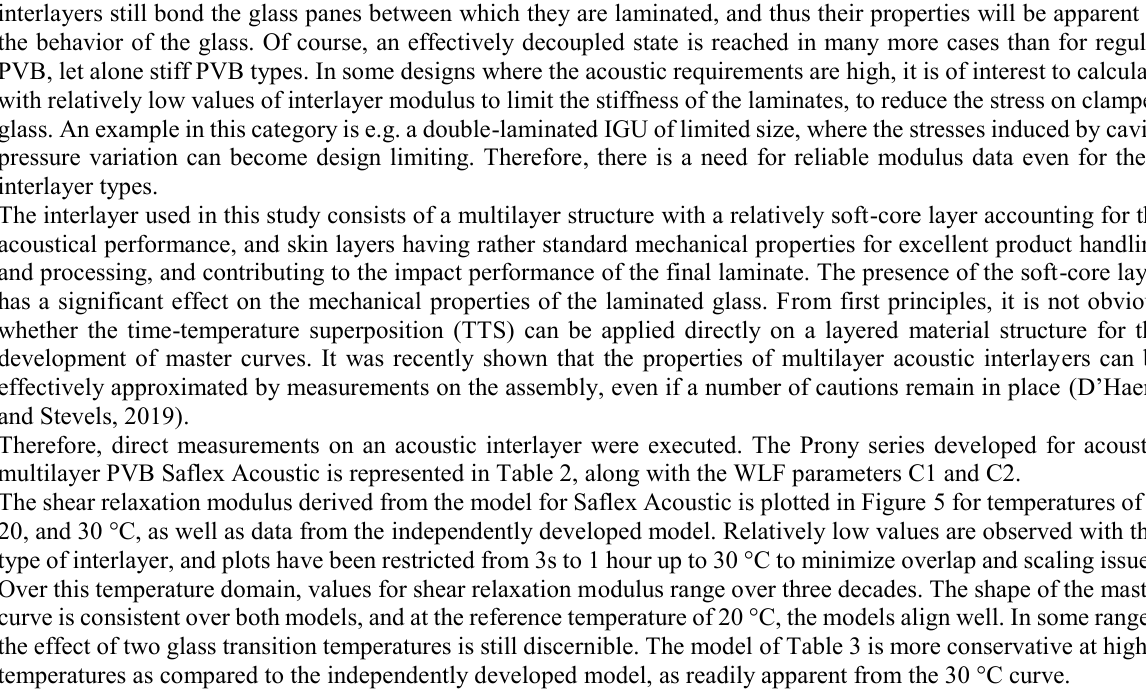
Table 2: Model parameters for the evaluation shear relaxation modulus G(t,T) for Saflex Acoustic QS (T ref = 20 °C). i Relaxation time Section [s]